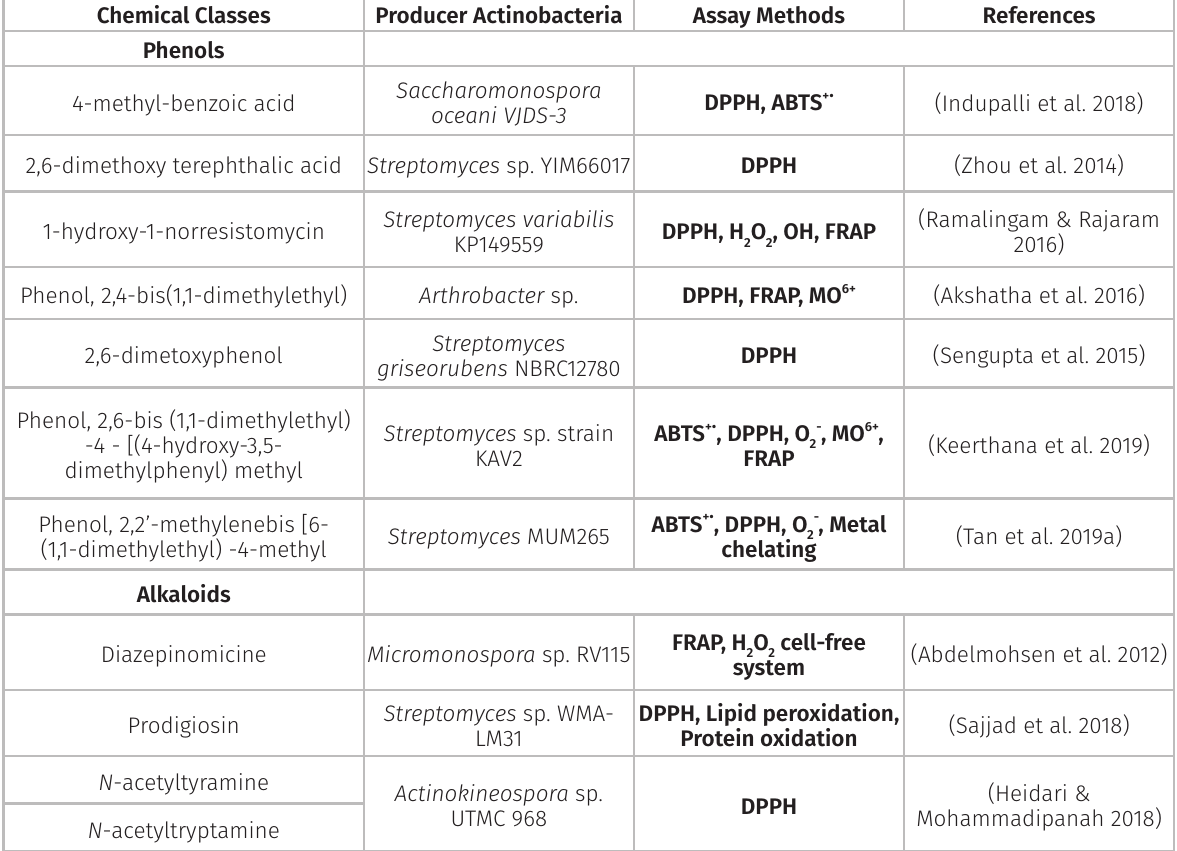
Table II. Phenolic and alkaloid antioxidative compounds from